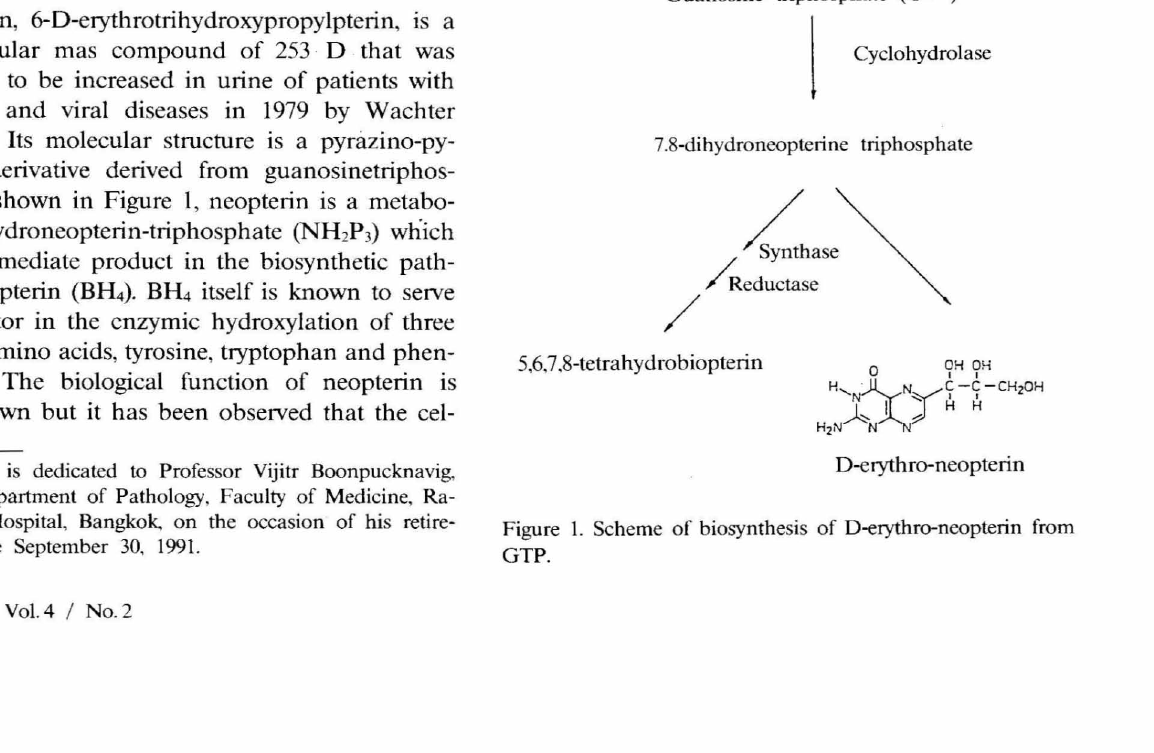
Figure I. Scheme of biosynthesis of D-erythro-neopterin from